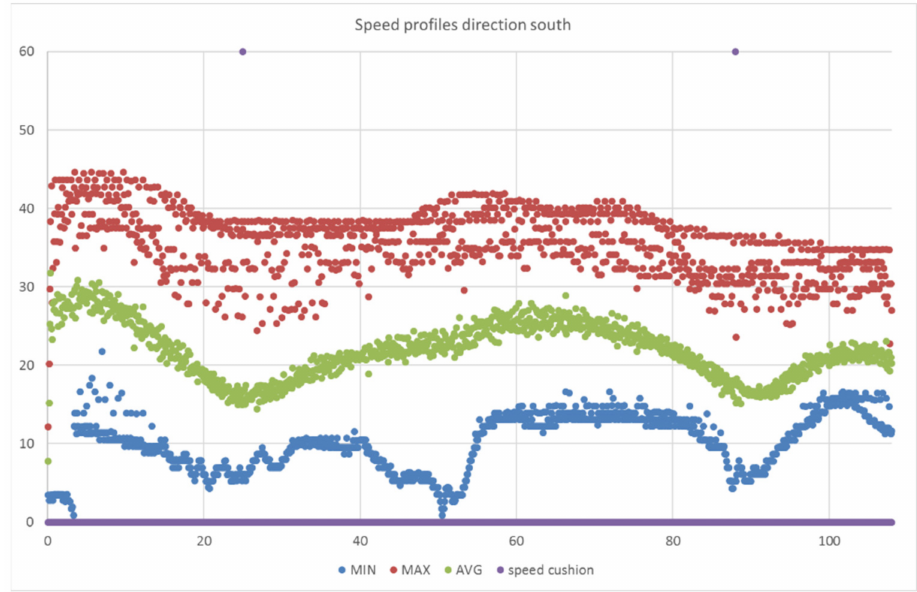
Figure 8. Speed profile for Stachiewicza street, direction southbound (source: